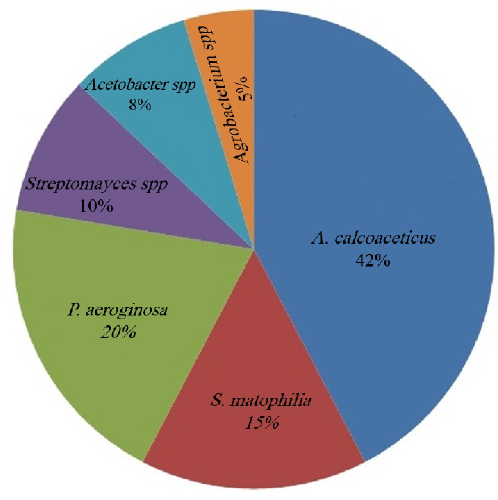
Fig. 3. The pie chart showing the frequency of endophytic isolates in sugar beet leaves.